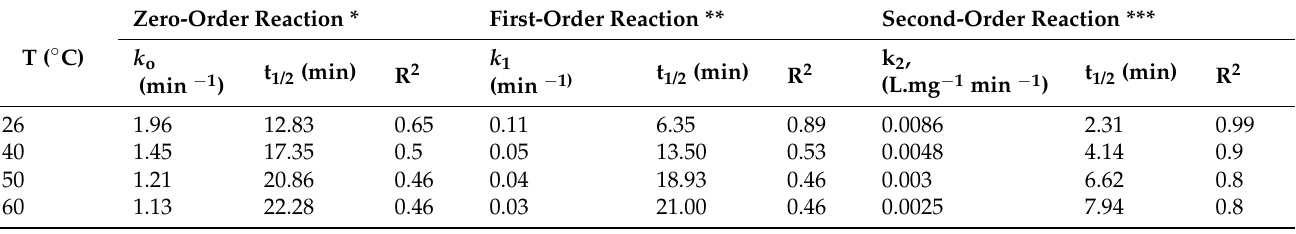
Table 4. Comparison of different kinetic models for WSD:Mag-based oxidation